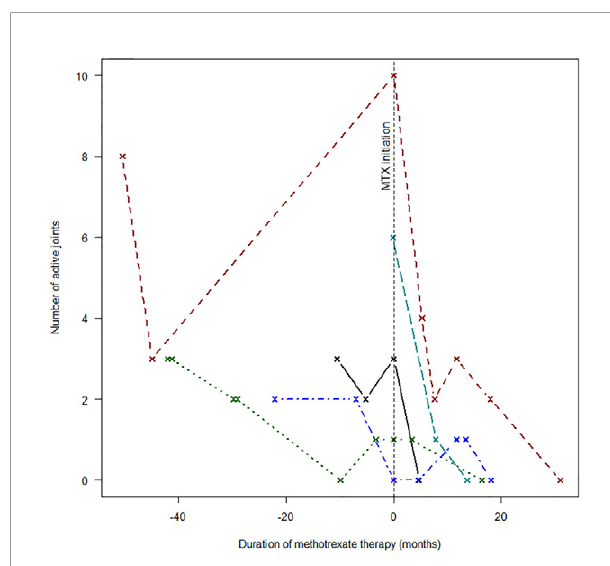
FIGURE 3 | Response to methotrexate therapy.